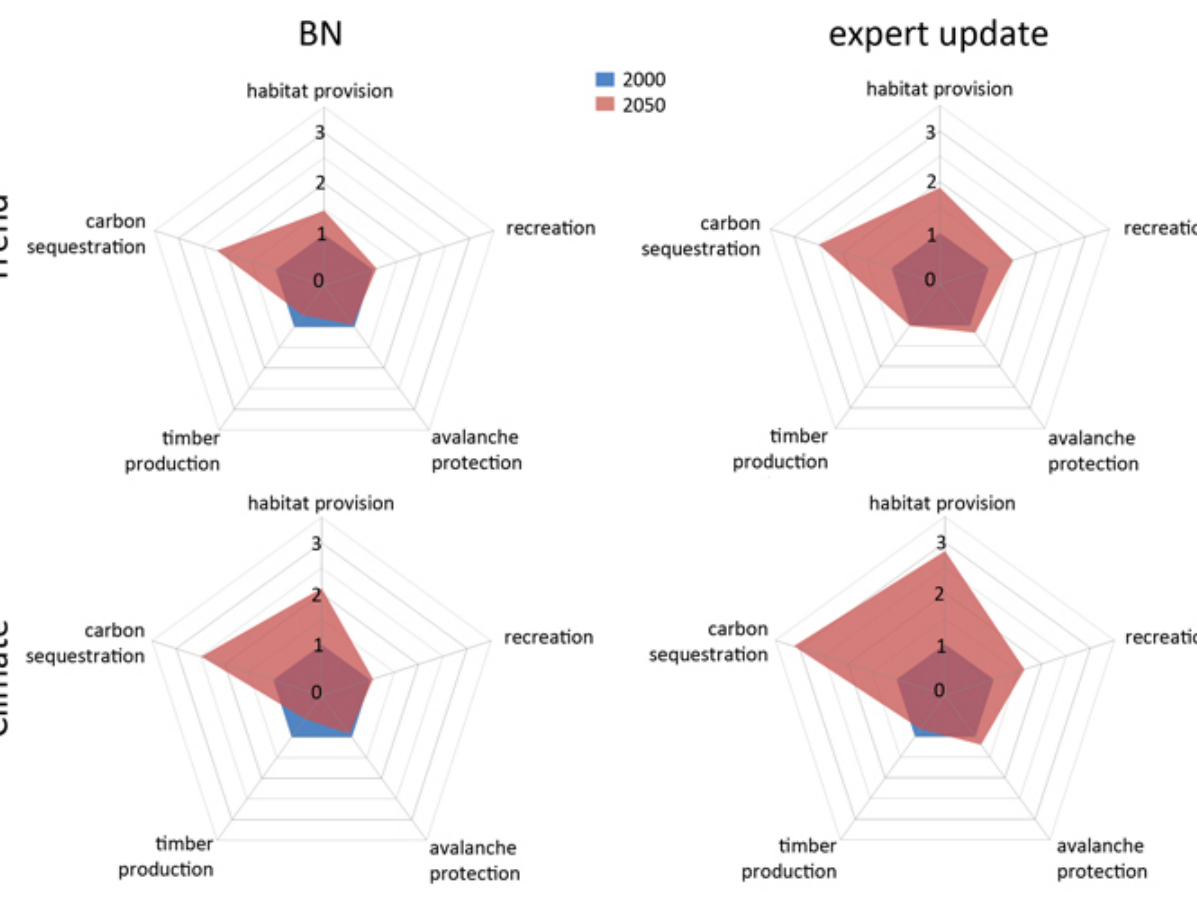
Fig. 5 . Trade-offs between the selected ecosystem services avalanche protection, recreation, carbon sequestration, habitat provision, and timber production in a selected stand under a trend and a climate scenario in 2050 calculated using a Bayesian network (BN) and including expert update. Ecosystem services values under the trend and climate scenarios were normed to the values in